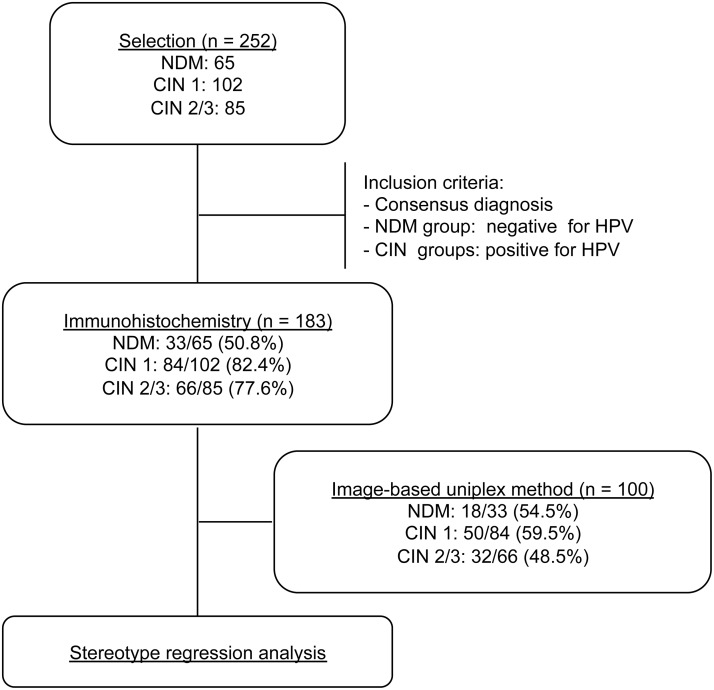
Study procedures and outcomes.The flow diagram shows the number of samples that were obtained from the laboratory file as well as those that were included in the immunohistochemistry and statistical analyses.